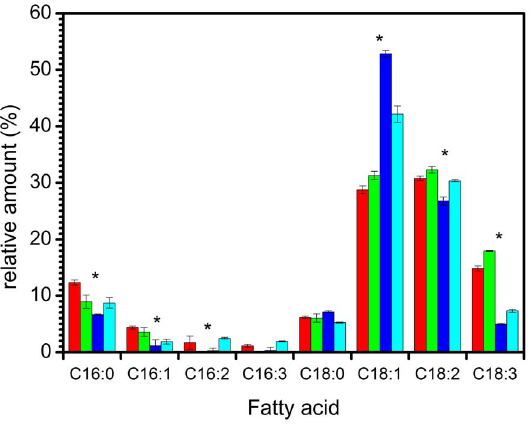
Figure 3. Total fatty acid distribution in Pichia pastoris cells grown in a hydrogenated environment at 30 6 C (red) and 18 6 C (green) and in a deuterated environment at 30 6 C (blue) and 18 6 C (cyan). Data represent mean values 6 s.d (n=3). In histograms, * P , 0.05 from Student’s t -test, assuming equal variance. For C16:0, there is a significant difference between H 30 u C and H 18 u C, between H 30 u C and D30 u C, H 30 u C and D18 u C, between H 18 u C and D 30 u C but not between H18 u C and D18 u C. For C16:1, there is a significant difference for all 4 different temperatures and isotopic contents. For C16:2, there is a significant difference between D30 u C and D18 u C. For C18:1, there is a significant difference for all 4 different temperatures and isotopic contents. For C18:2, there is a significant difference between D30 u C and H30 u C, between D30 u C and D18 u C, between D30 u C and H18 u C. For C18:3, there is a significant difference for all 4 different temperatures and isotopic contents. of d 8 -glycerol as a sole carbon source. Indeed, molecular ions at m/z 438 in the case of ergosteryl acetate (Figure 5C), and at m/z 481 in the case of deuterioergosteryl acetate (Figure 5D), confirmed the formula C 30 H 46 O 2 and C 30 D 43 H 3 O 2 for the analyzed isotopomers. In addition, GC-MS analysis of the underivatized extract revealed molecular ions at m/z 396 or at m/z 440 (spectra not shown), in full agreement with ergosterol (C 28 H 44 O) or deuterioergosterol (C 28 D 44 O), respectively. Discussion 1. Desaturation of fatty acid in yeast